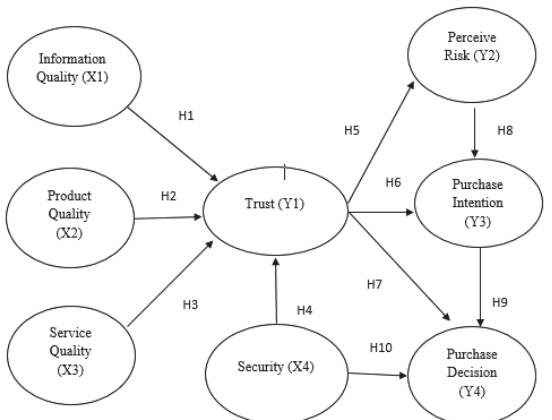
Fig. 1. The proposed study (Ingham & Cadieux, 2016; Shao et al., 2019; Mohseni et al., 2018; Al-Adwan, 2019; Schena,